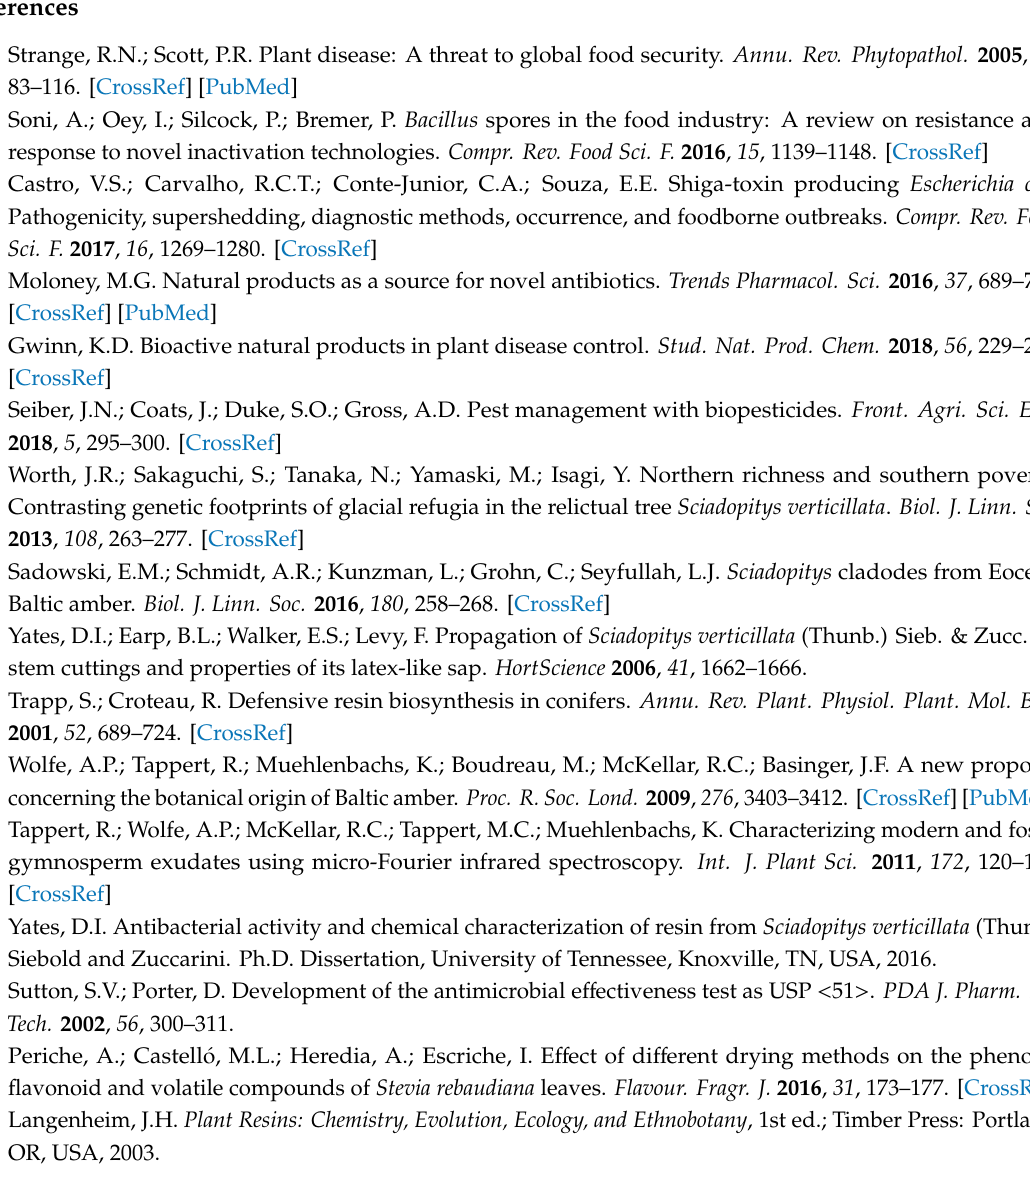
Supplementary Materials: The following are available online, Figure S1: Sciadopitys verticillata resin, Figure S2: Standard curve used to calculate concentration of 1R- α -pinene in resin, Figure S3: Impact of Sv resin on growth of phytopathogenic bacteria, Agrobacterium tumefaciens and Xanthomonas perforans , Figure S4: Antimicrobial activity of autoclaved Sv resin against Escherichia coli